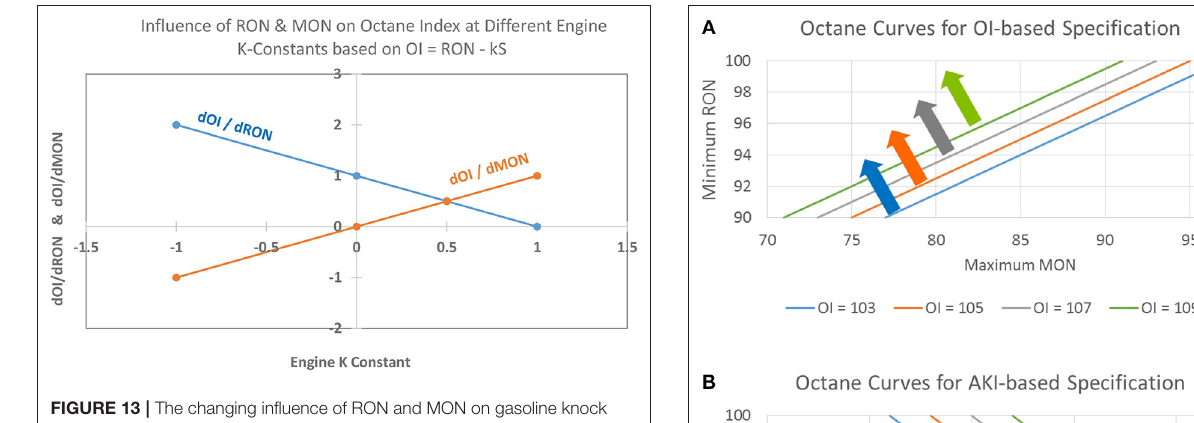
FIGURE 13 | The changing influence of RON and MON on gasoline knock resistance at different engine K constants. As modern engines trend toward negative K -values, MON becomes negatively correlated to octane index and its influence on gasoline antiknock quality diminishes relative to RON. Conversely, both, the U.S’s AKI and the EU’s RON and MON methods place equal emphasis on RON and MON.